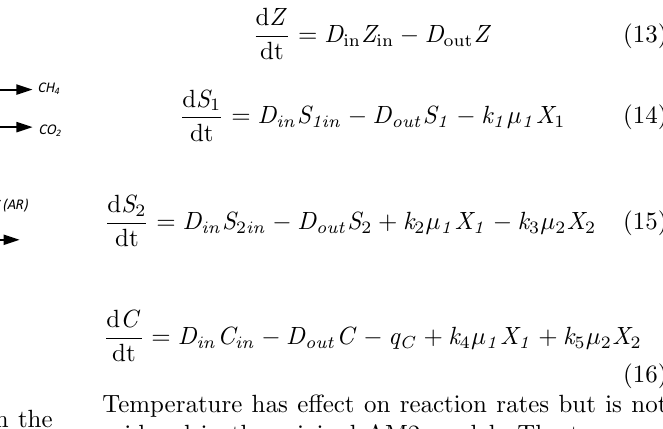
Figure 3: A block diagram of an AD reactor with the AM2 model